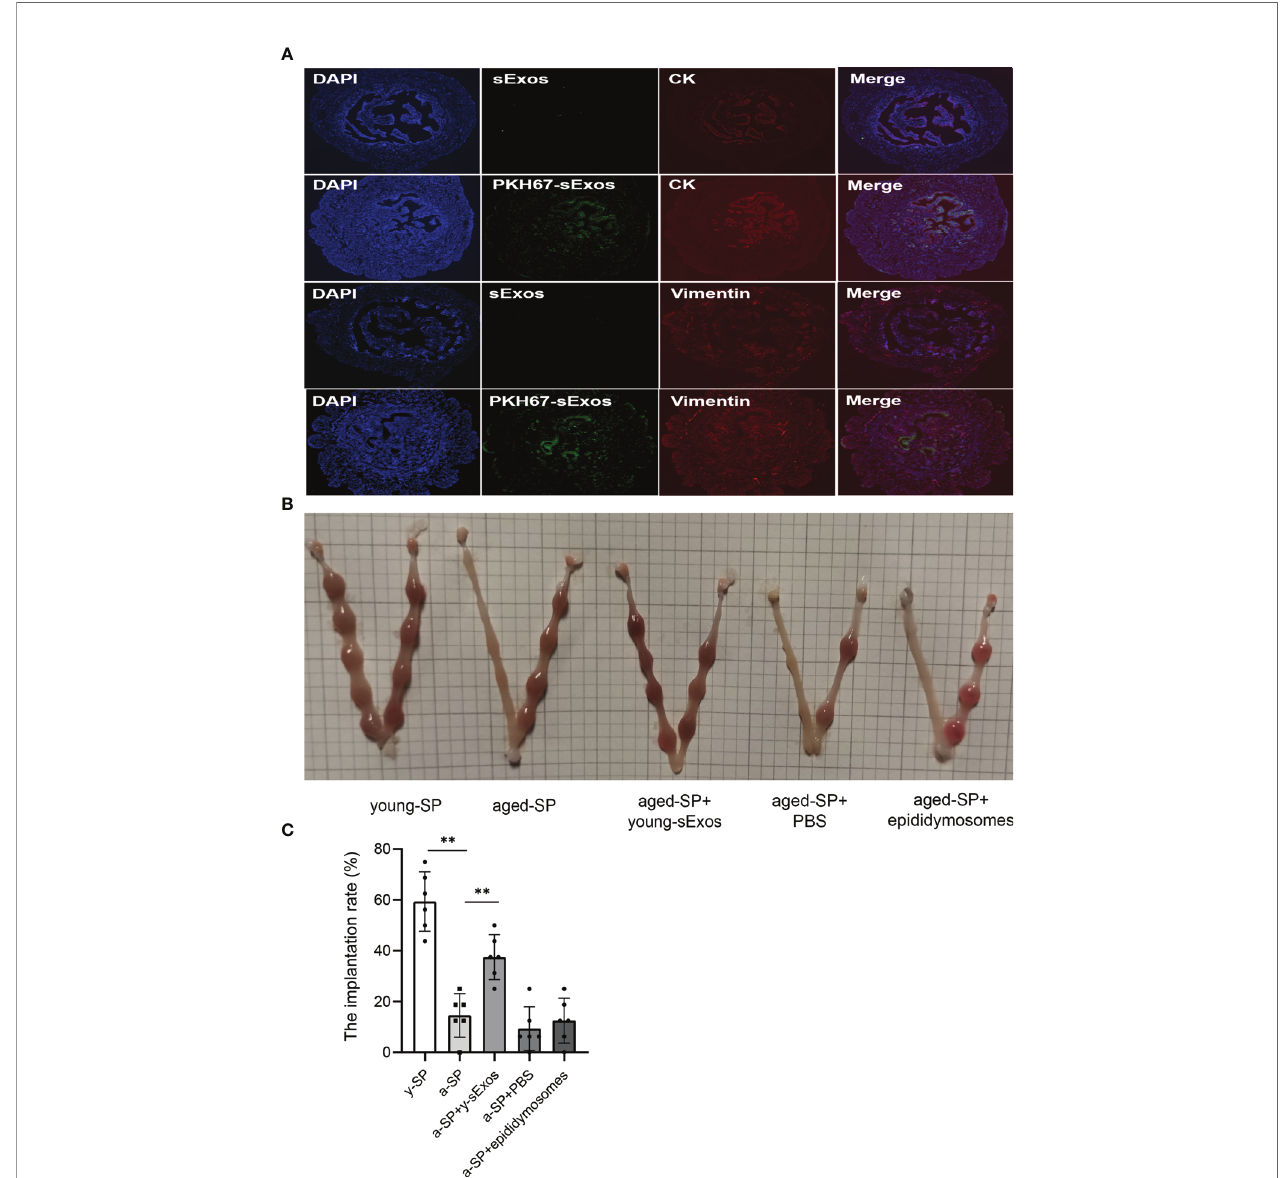
FIGURE 6 | The increase of embryo implantation rate after perfusion with young sExos in the aged-SP group. (A) Immuno fl uorescence staining of the uteri after perfusion with sExos from young male mice. Red fl uorescence shows antibody reactivity against Vimentin and Cytokeratin 19, green fl uorescence shows PKH67- labeled sExos, and blue fl uorescence shows nuclear DAPI reactivity (magni fi cation, ×200). (B) Embryo implantation sites of young-SP, aged-SP, aged-SP+young- sExos, aged-SP+PBS, and aged-SP+epididymosomes group female mice on 6.5 dpc. (C) Quantitative histogram of the embryo implantation rates in fi ve groups of recipient female mice as seen in panel B (mean ± SD, n = 6).The differences among different groups were assessed by one-way ANOVA with Holm – Sidak post-hoc test. **p < 0.01. sExos, seminal plasma exosomes; SP, seminal plasma; PBS, phosphate-buffered saline; dpc, days post